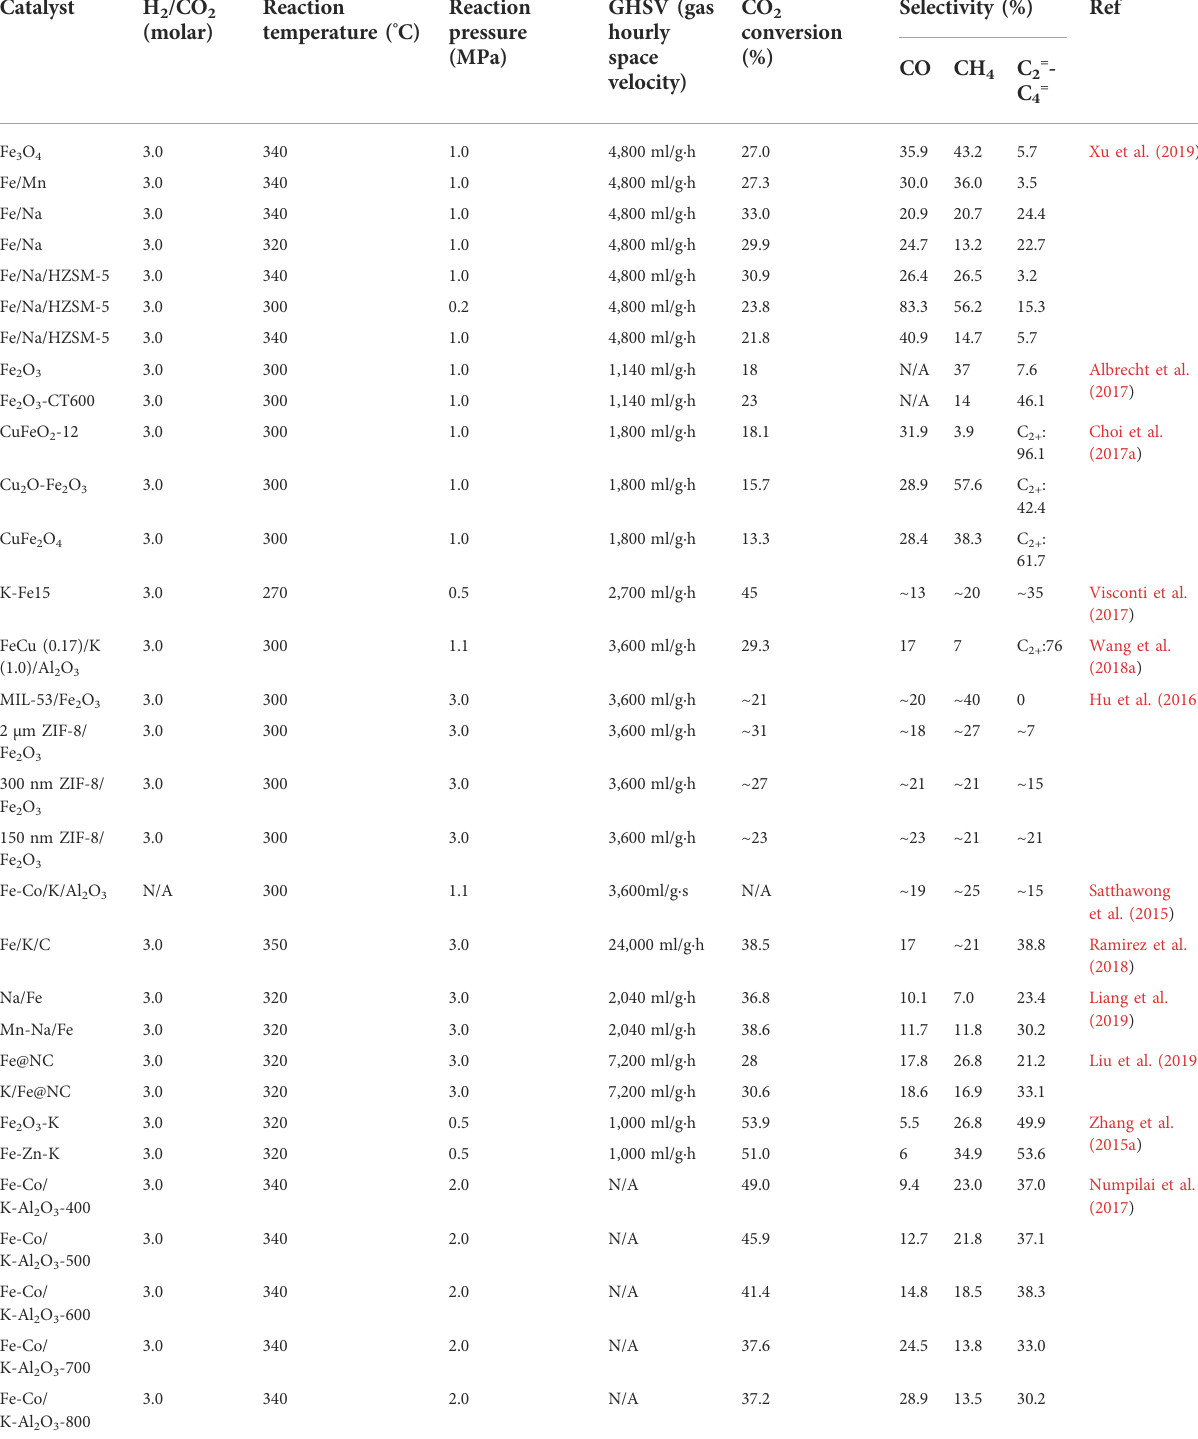
TABLE 1 Catalytic performances for the CO 2 conversion into light ole fi